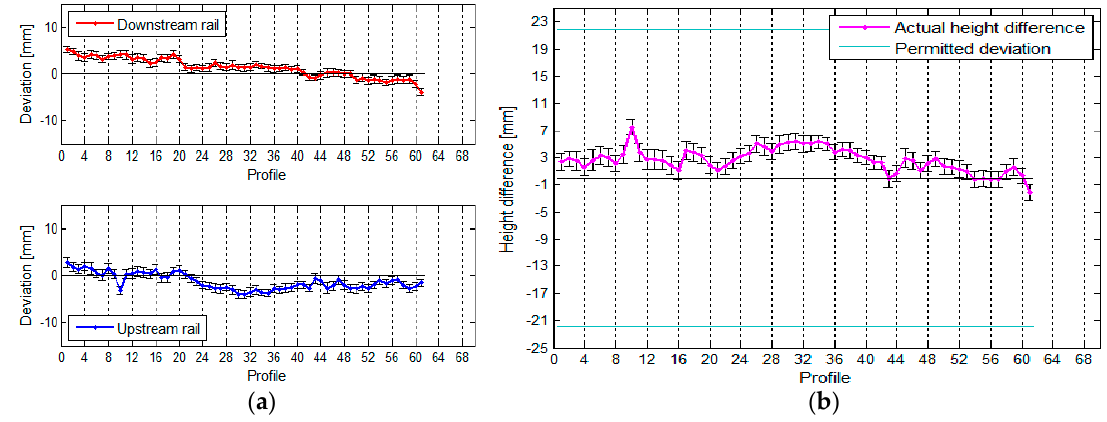
Figure 14. ( a ) The positional deviation of the rails and ( b ) the span between them, with their standard deviations, for the crane in the HPP in Krško measured with TLS.